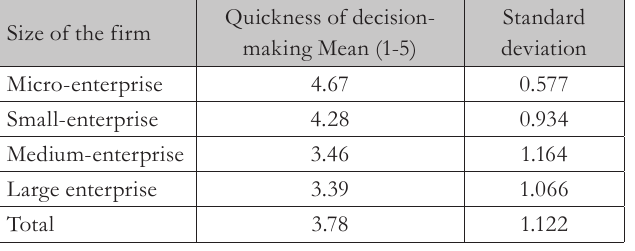
Tab. 1 – The quickness of decision-making in organisation of suppliers. Source: own Size of the